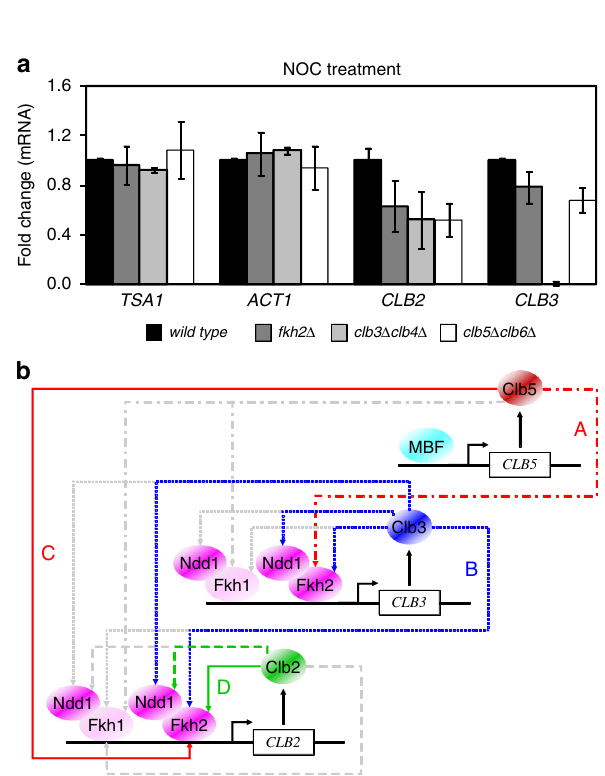
Fig. 4 a Quantitative real-time PCR of mitotic CLB transcripts in yeast cells treated with nocodazole. Total mRNA was isolated from arrested wild type, fkh2 Δ , clb3 Δ clb4 Δ , or clb5 Δ clb6 Δ cells, and CLB2 and CLB3 mRNA levels were measured. ACT1 and TSA1 genes were used as negative controls, as they are not affected by cell cycle dynamics. Error bars on the histograms represent SDs from the mean of three independent experiments; p -values are indicated on the histograms in Supplementary Fig. S5h. Nocodazole-arrested cells show that clb3 Δ clb4 Δ affects CLB2 transcript accumulation, whereas clb5 Δ clb6 Δ affects both CLB2 and CLB3 transcript accumulation. b Schematic view of the regulatory connections involving the Fkh/ Ndd1 and Clb/Cdk1 complexes. Colored solid arrows refer to the known interactions reported in literature; colored dashed arrows refer to the newly unraveled interactions between Fkh2/Ndd1 and Clb/Cdk1 complexes; gray dashed arrows refer to the newly unraveled interactions between Fkh1/Ndd1 and Clb/Cdk1 com- plexes. See text for